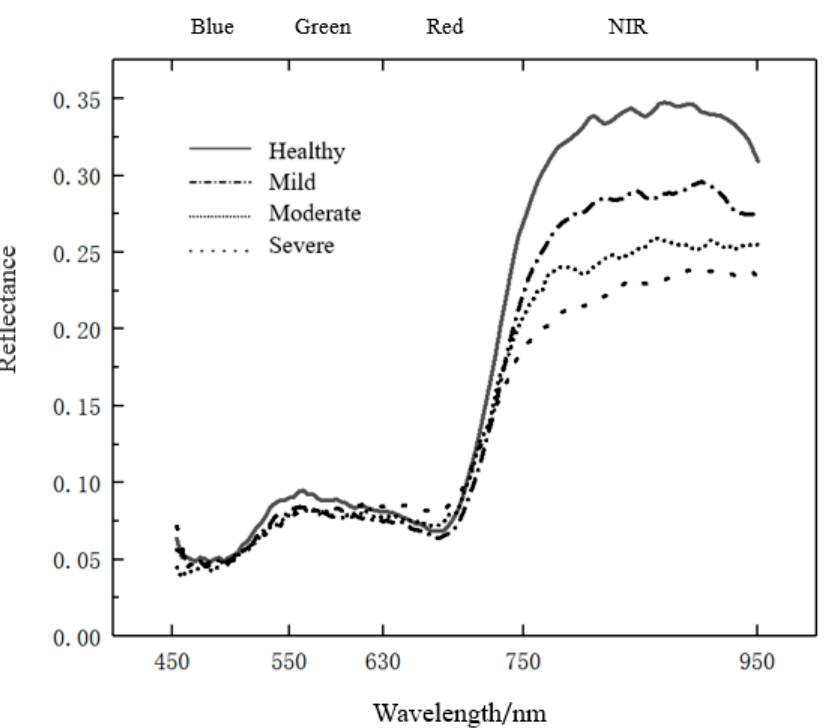
Figure 3. Spectral curves of wheat with different disease grades.